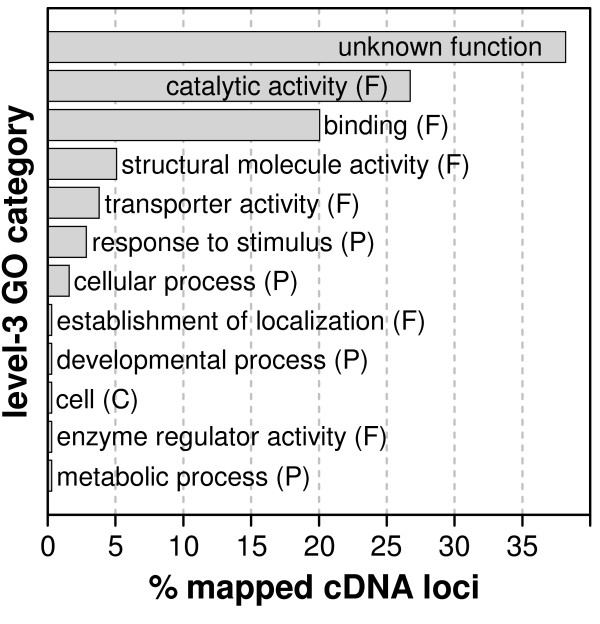
Comparison of GO categories for mapped cDNA sequences. Percentages of general GO term category assignments found among mapped cDNA marker loci in P. taeda. GO terms for similar functions, processes or cell compartments were grouped by standardizing them to level-3 of the GO lineage hierarchy, where level-1 is 'all' and level-2 comprises the three ontologies: 'molecular_function' (F), 'biological_process' (P) and 'cellular_compartment' (C). Assigned GO terms and the parental GO lineages (levels-3, -4 and -5) for individual markers are in Additional file 8